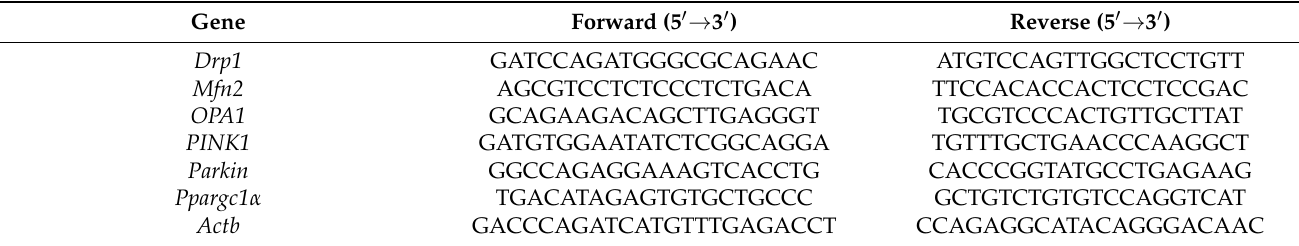
Table 1. List of gene-specific primers for the real-time PCR